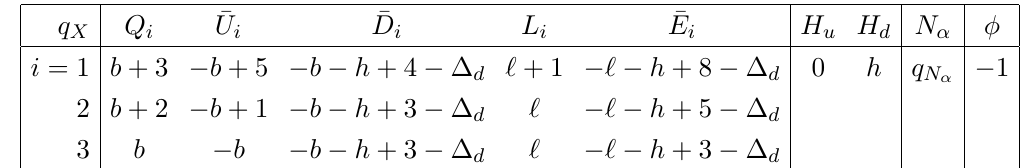
The scale of the (cid:22) -term is controlled by the parameter h , i.e., the U(1)